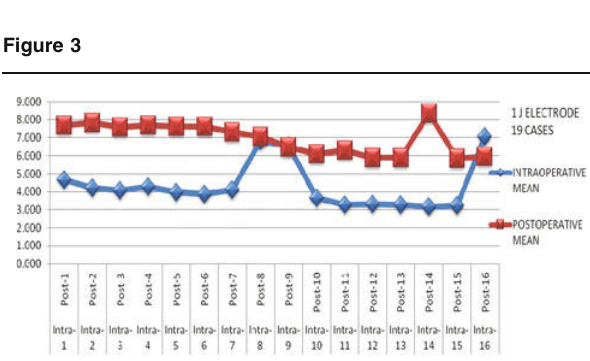
Distribution of the number of patients by category of type of surgical approach.